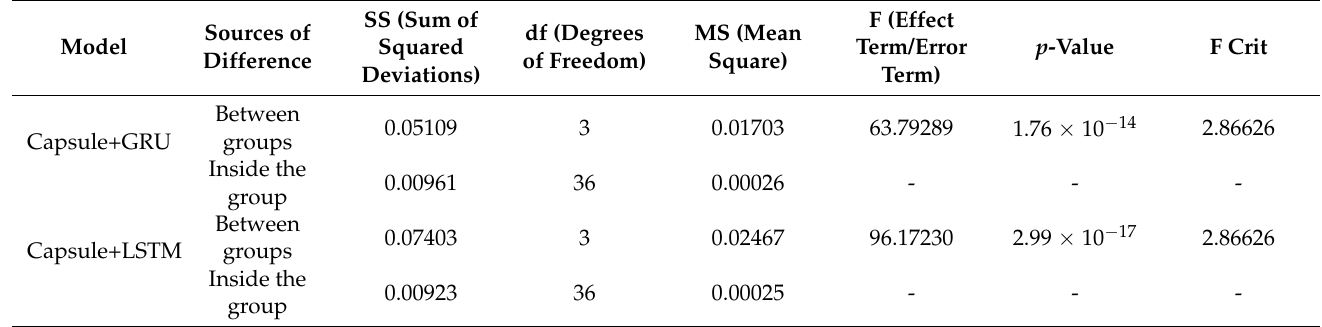
Table 3. Anova test results.